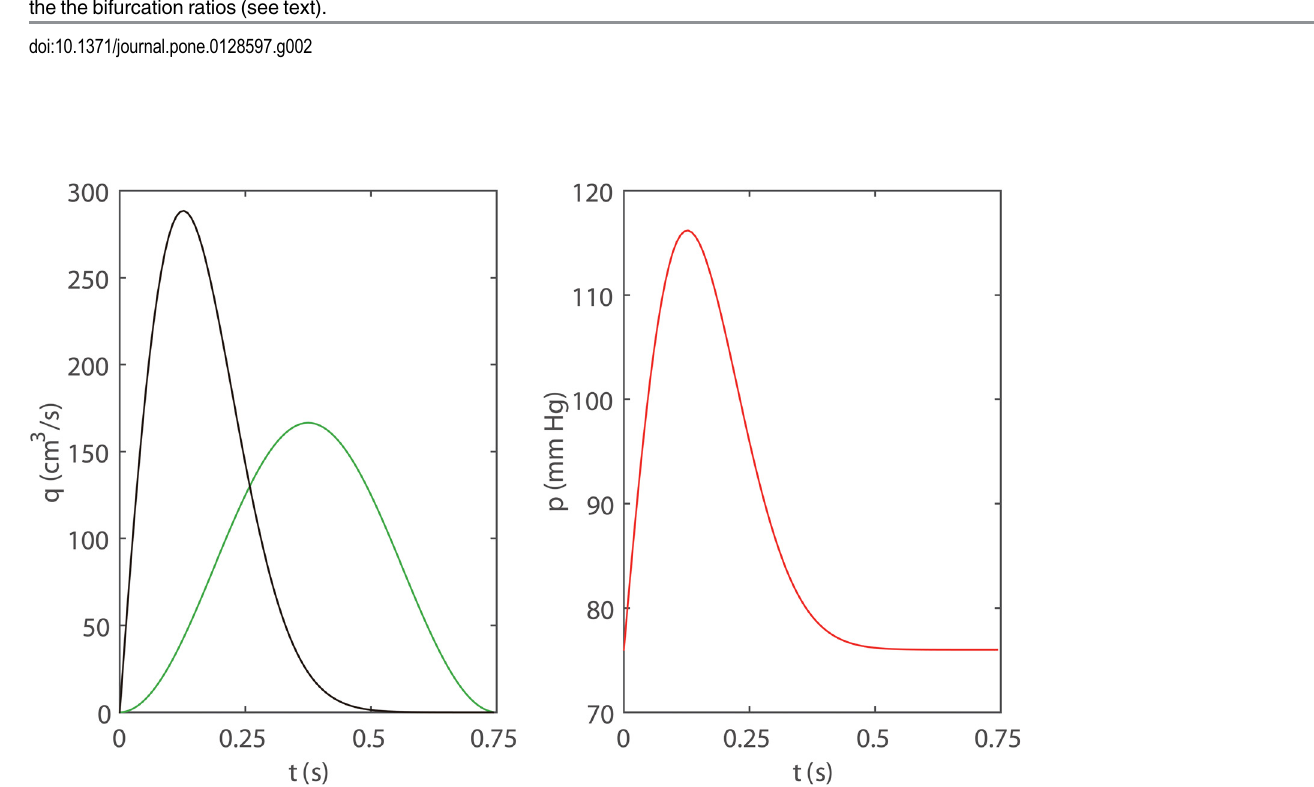
PLOS ONE | DOI:10.1371/journal.pone.0128597 May 22,